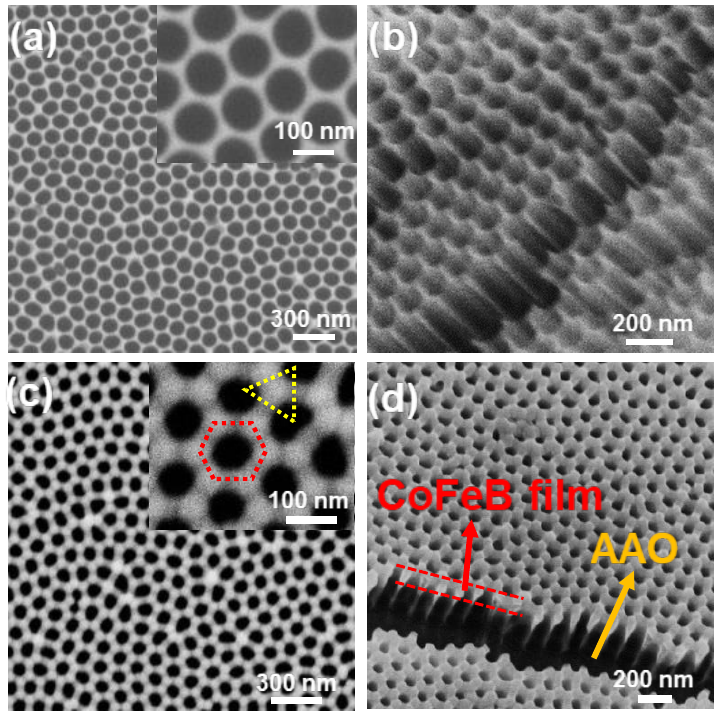
Figure 4. ( a ) Wide surface and ( b ) cross section SEM images of a porous AAO film (pore diameter, 90 nm; inter-pore spacing, 110 nm) without any coating. ( c ) Surface SEM image of a 51 nm thick CoFeB film fabricated on the AAO substrate of 90 nm pore diameter. ( d ) Cross section SEM image of thin films coated with 51 nm CoFeB layer on the AAO substrate of 90 nm pore diameter.